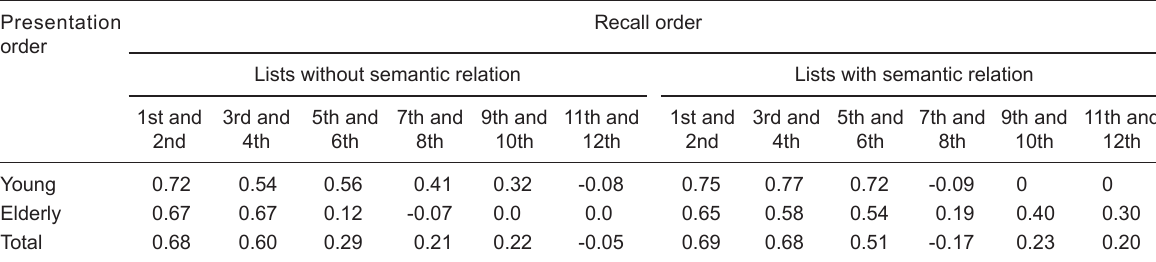
Table 2. Significant correlations between recall order and presentation